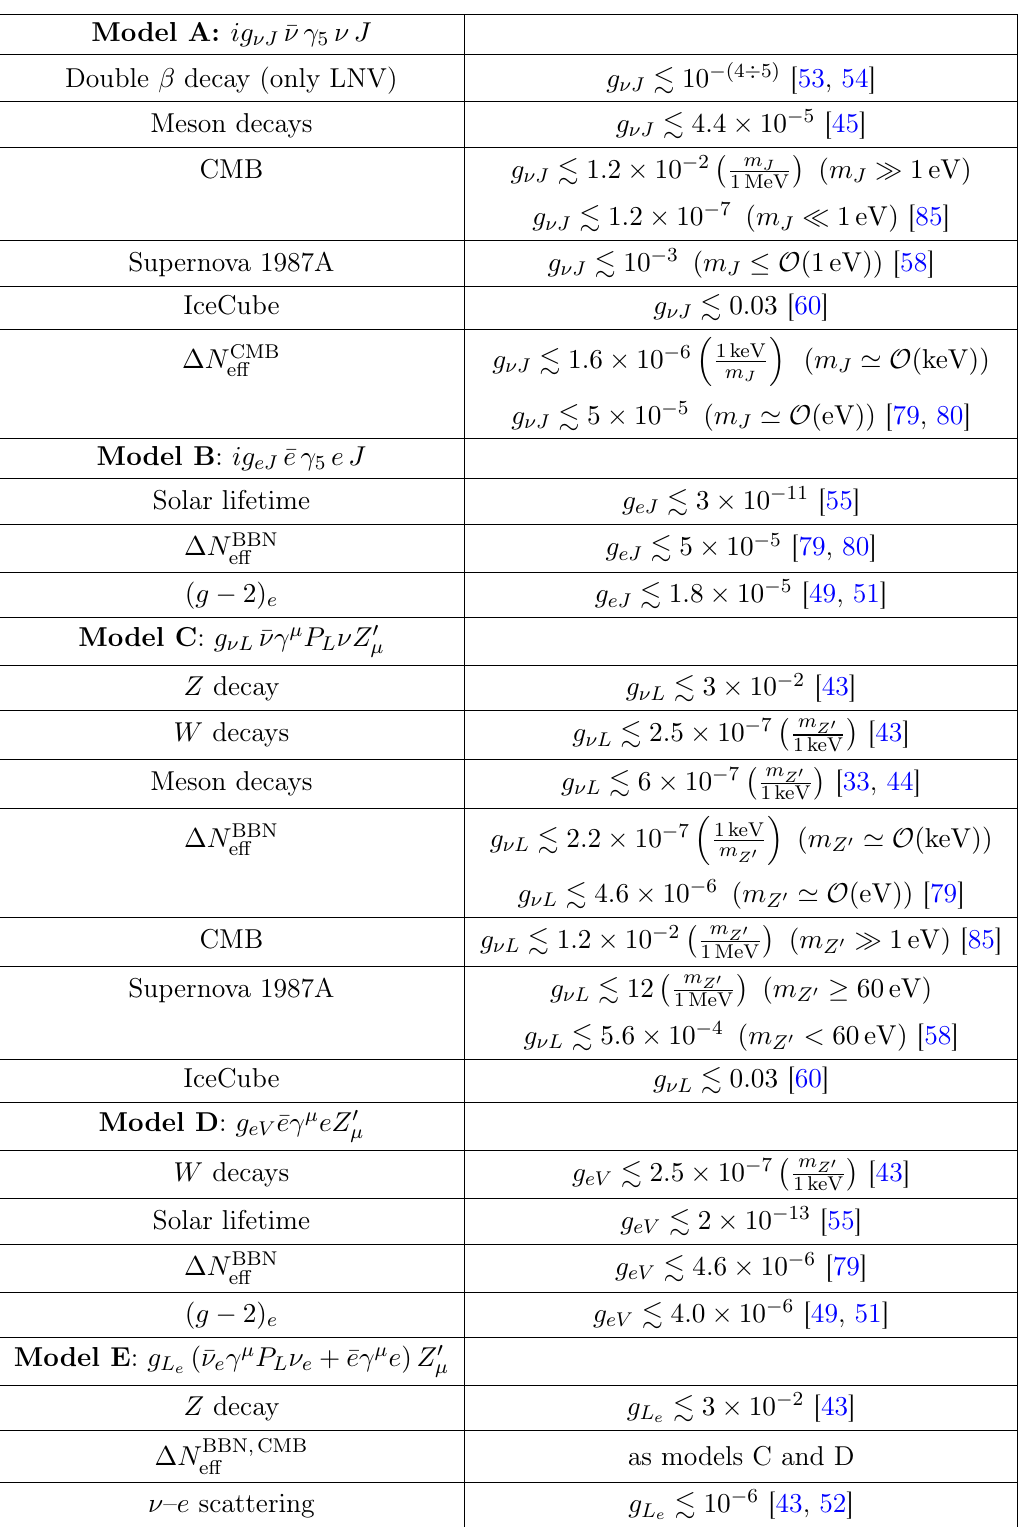
Table 2 . Summary table including all the laboratory, astroparticle, and cosmological constraints which apply to the models considered in this work; LNV = lepton number violating